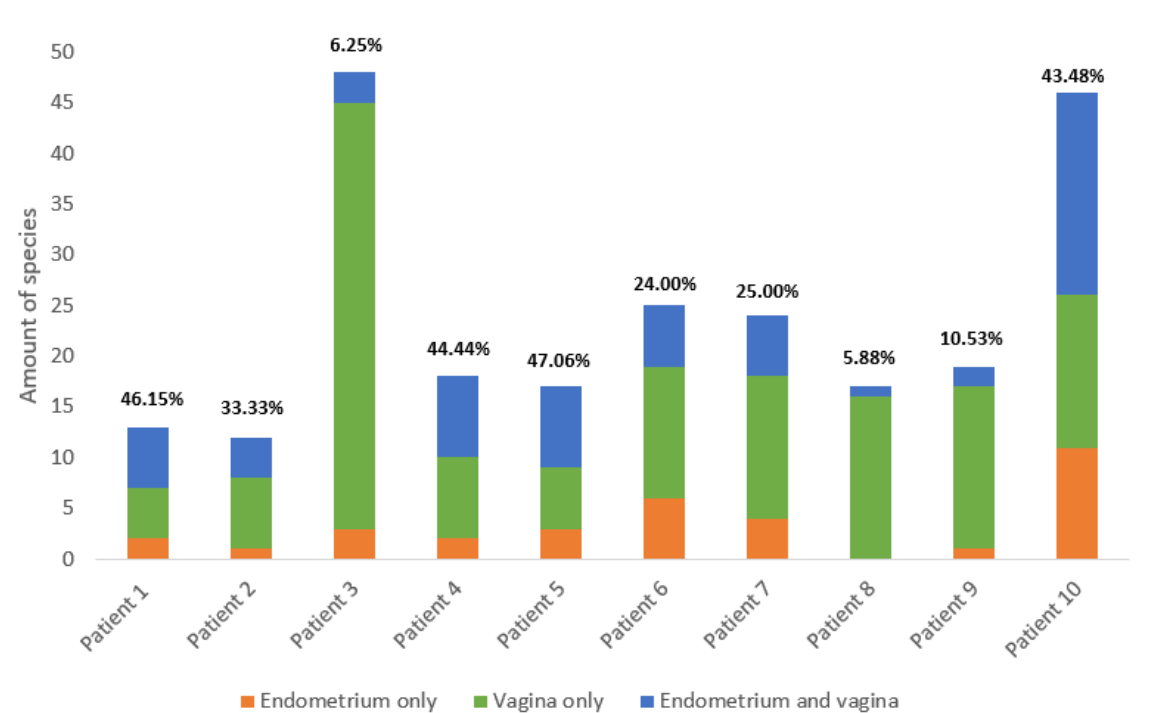
Figure 3. Summary of the number of species in the vagina and endometrium across all 10 patients. The proportion of species identified only in the endometrium is colored orange, the proportion identified only in the vagina is colored green, and the proportion identified in both vagina and endometrium is colored blue. The concordance ((species found in both vagina and endometrium/all species found) * 100) of species between the vaginal and endometrial microbiota is given above the corresponding bars. Detailed information per patient is available in the Supplementary Materials.